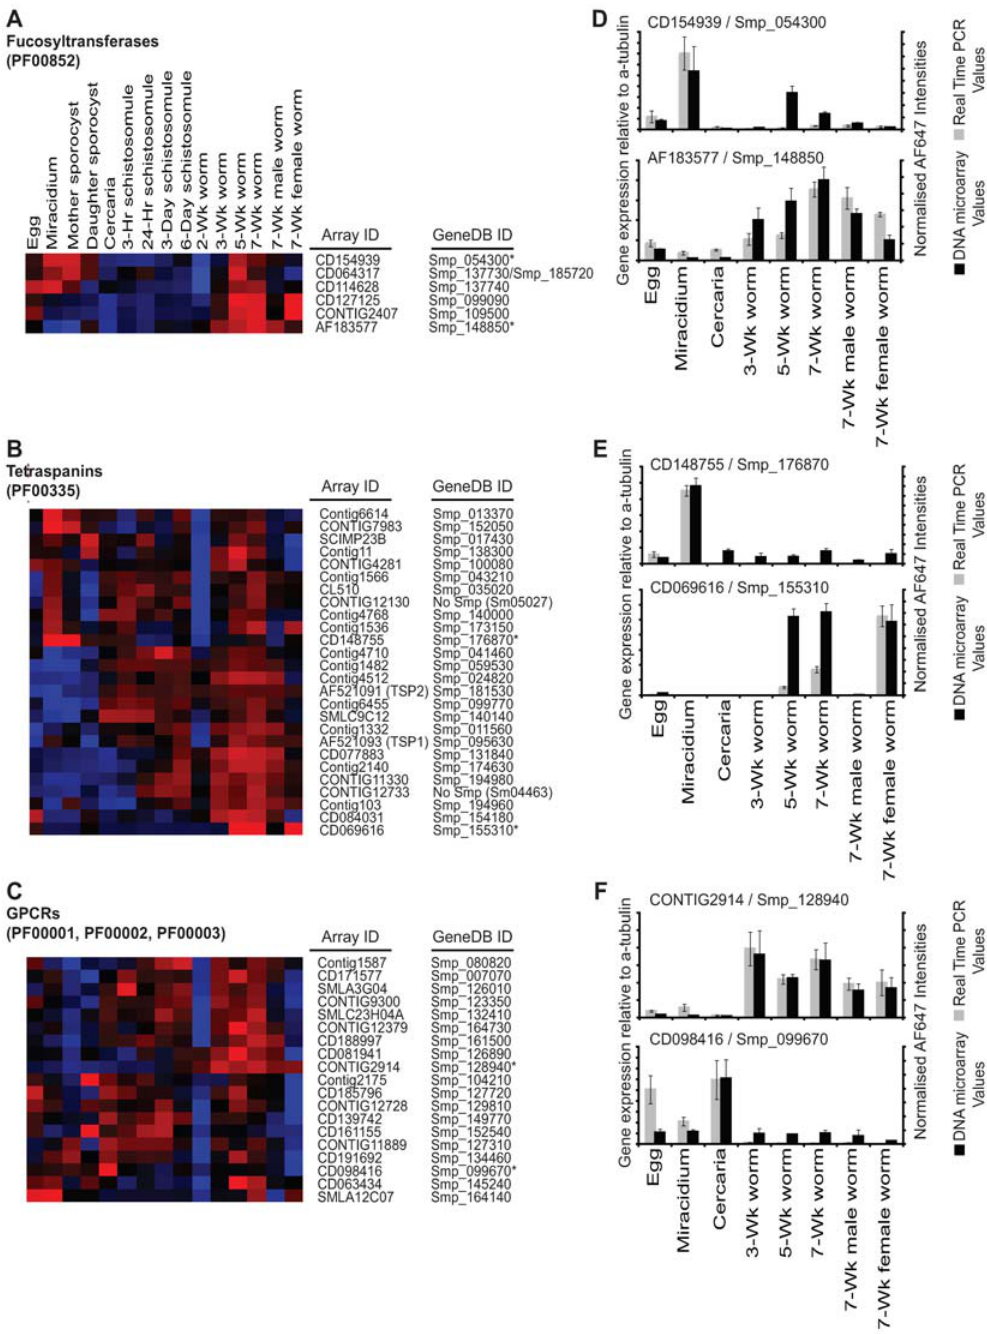
Figure 7. Analysis of three important schistosome gene families reveals differential transcription of individual members across the parasite’s lifecycle. Using the latest version of the schistosome genome assembly (version 4.0), all putative fucosyltransferase- (PF00852, Dataset S7), tetraspanin- (PF00335, Dataset S8) and GPCR- (PF00001, PF00002 and PF00003, Dataset S9) family members were identified. DNA microarray oligonucleotides were mapped to specific regions of the predicted genes using the S. mansoni genome browser function of S. mansoni GeneDB [25]. For those predicted gene family members where 50-mer oligonucleotides could be mapped, expression data was extracted and analysed. Heatmap representation of all S. mansoni : A) fucosyltransferases (PF00852), B) tetraspanins (PF00335) and C) GPCRs (PF00001, PF00002 and PF00003) differentially expressed across the parasite’s lifecycle (all data included in Datasets S7–9. Heatmaps (red – highly expressed, blue – weakly expressed) were created from normalised AF647 intensities using a Spearman’s rank correlation coefficient and average linkage clustering ( Methods ). Corresponding real time RT-PCR confirmation of selected family members (*) (D – fucosyltransferases: CD154939/Smp_054300 & AF183577/ Smp_148850; E – tetraspanins: CD148755/Smp_176870 & CD069616/Smp_155310; F – GPCRs: CONTIG2914/Smp_128940 & CD098416/Smp_099670) is indicated to the right of heatmap.